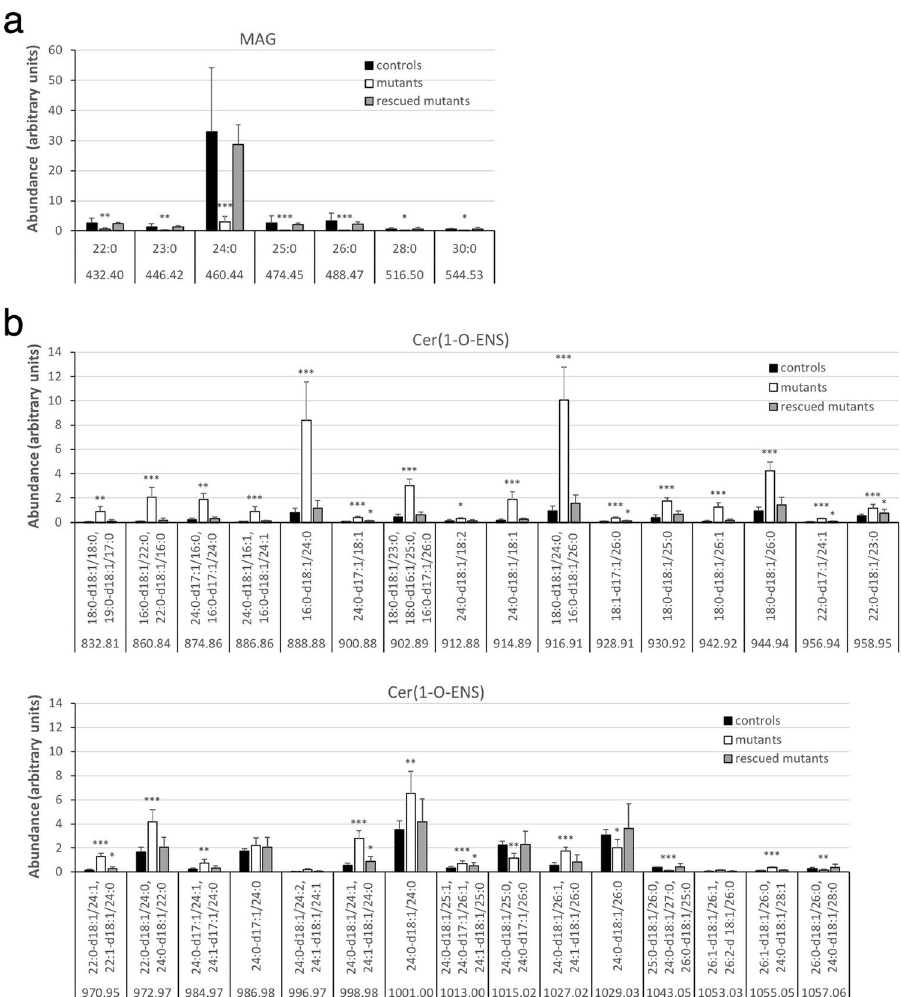
Figure 8. Alterations in MAG and 1-O-acylceramide content in unbound epidermal lipids in Fatp4 − / − mice. Fractions 3 and 2 of unbound epidermal lipids of newborn mice were analyzed by ESI-MS in the positive-ion mode as [M + NH 4 ] + ions ( a ) and as [M + H] + ions ( b ), respectively, and quantified in arbitrary units. The decreased levels of MAG species seen in Fatp4 − / − mice were all normalized by the Fatp1 transgene ( a ). Fatp4 − / − mice showed increased levels of many Cer(1-O-ENS) species that carried 48 or fewer total carbons in their two acyl chains, almost all of which were normalized by the Fatp1 transgene ( b ). Data were obtained from 4 each of Fatp4 + / − (controls), Fatp4 − / − , and FATP1-rescued mutants with m/z ratios, standard deviation, and statistical significance shown ( * P < 0.05; ** P < 0.01; *** P < 0.001). See Materials and Methods for nomenclature. MAG species are listed by their acyl groups. Cer(1-O-ENS) species at the same m/z ratio are listed in descending order in amount found in